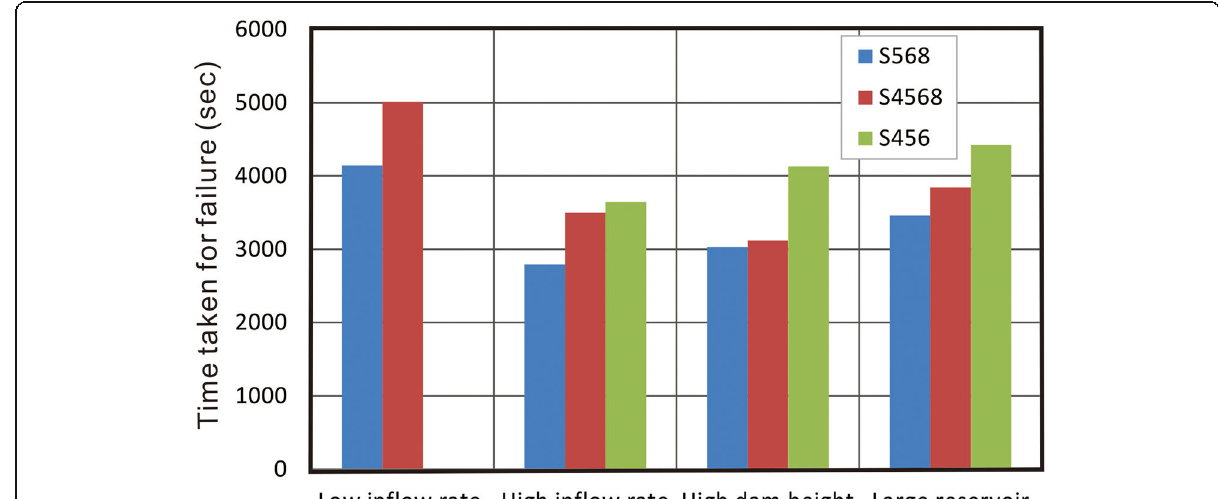
Fig. 10 Time taken for failure of dam crest for different